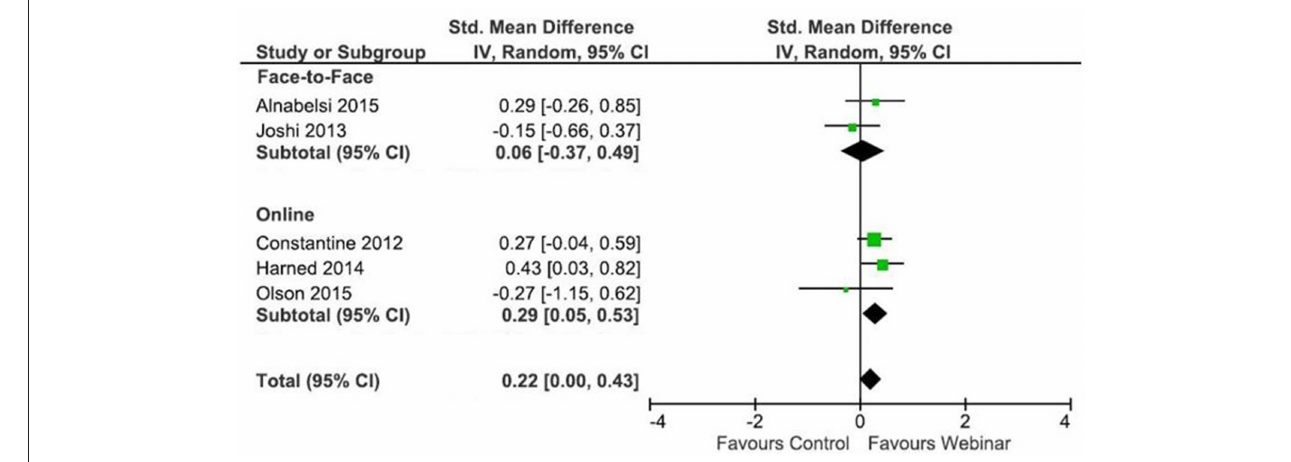
FIGURE 3 | Forest plot of learning effect sizes.